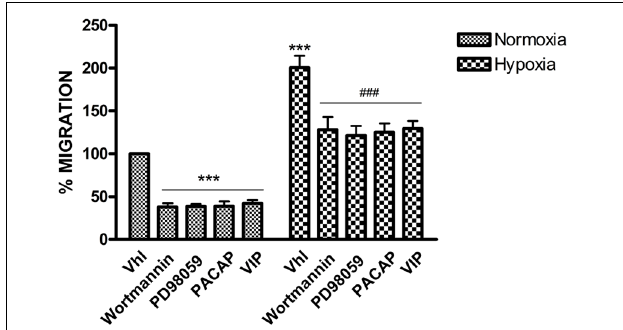
FIGURE 3 | Effect of PACAP, VIP, PI3K, and MEK1 inhibitors on U87-MG cells migration. Cells monolayer was scraped by a pipette tip and incubated with PACAP, VIP, Wortmannin or PD98059 for 24 h under normoxia or hypoxia. The wounded areas were visualized under a microscope for quantification. Migration was calculated as the average number of cells observed in five random high power wounded fields/per well in duplicate wells. In the bar graph values are expressed as percentage of control. ( ∗∗∗ p < 0.001 vs. Vhl under normoxia; ### p < 0.001 vs. Vhl under hypoxia).